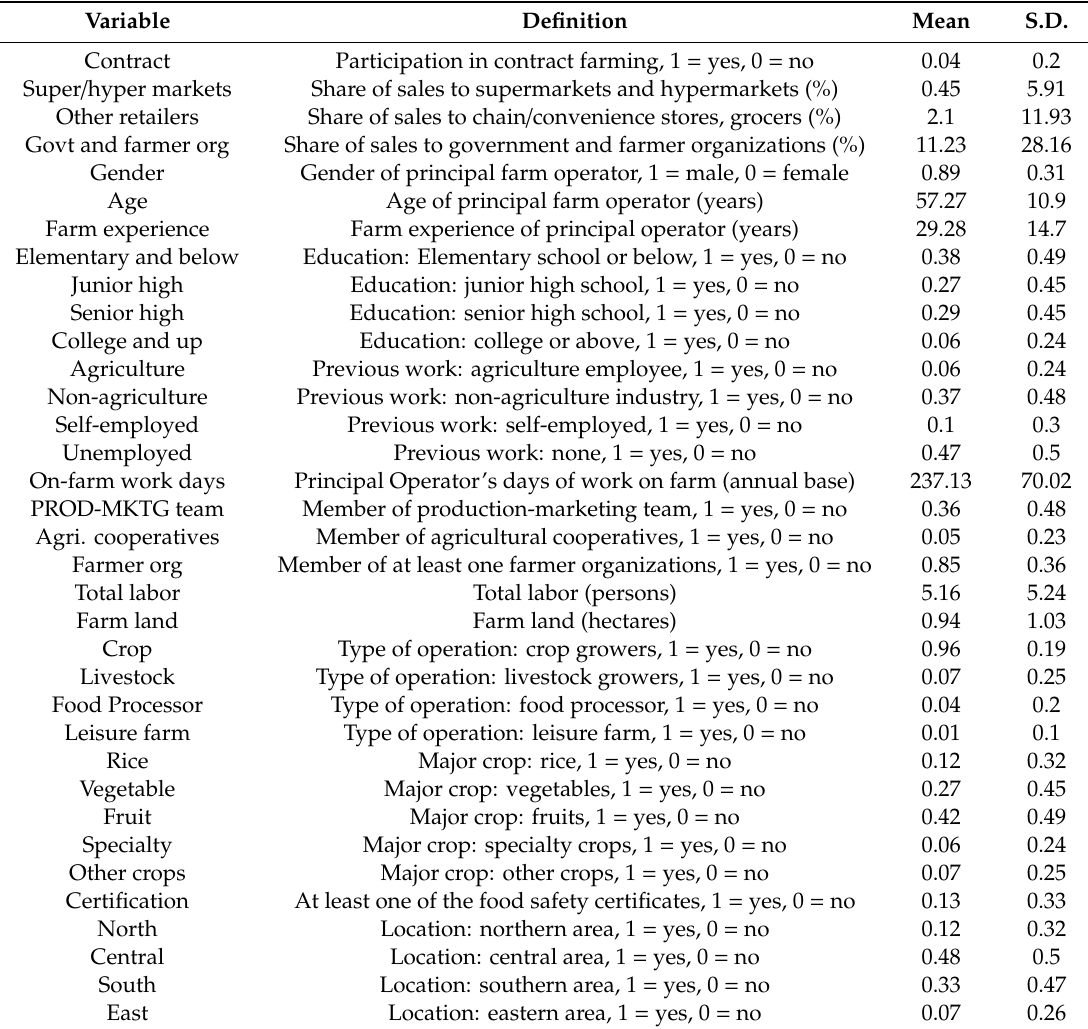
Table 1. Variable definition and descriptive